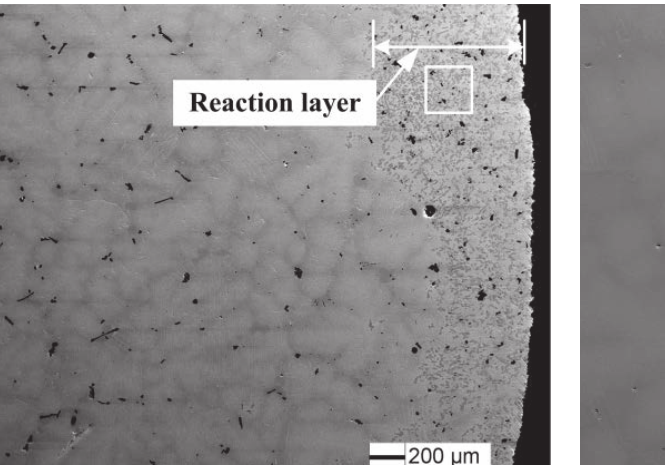
Fig. 1: SEM micrograph of the Ti-47Al-2Cr-2Nb sample obtained by alumina mould.